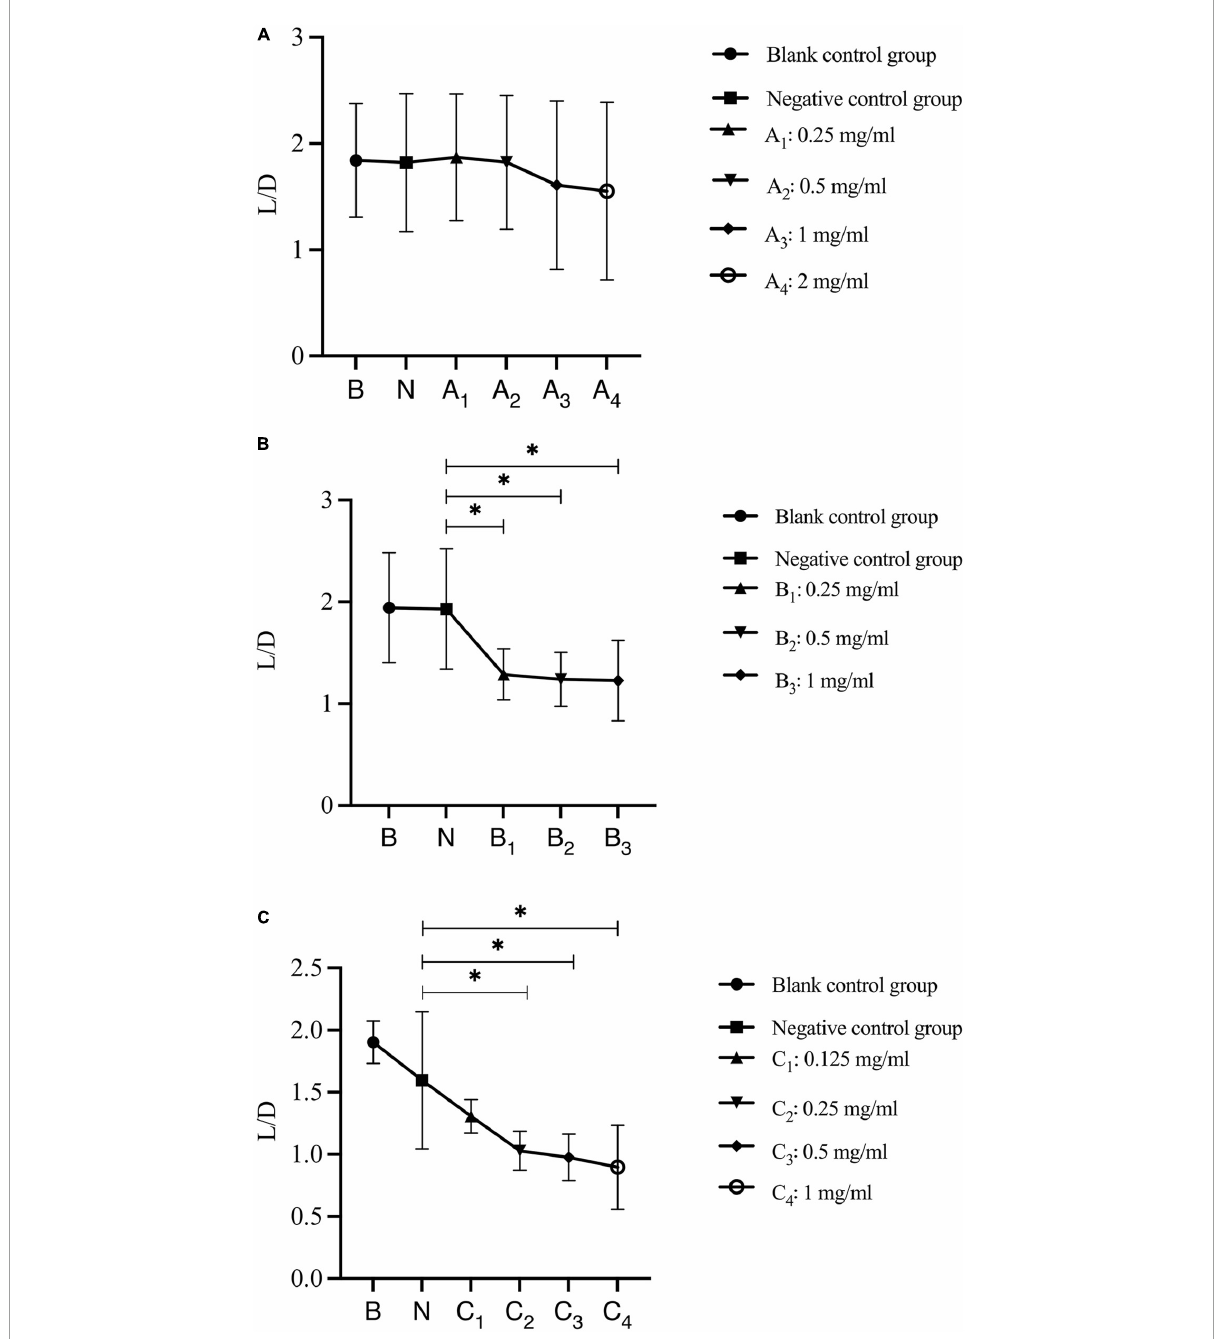
FIGURE8 Changes in the ratio of live/dead bacteria after bovine trypsin treatment for 30 s, 1 min, and 3 min. (A–C) Show the quantitative analysis of the ratio of live bacteria/dead bacteria in the biofilms after 30 s, 1 min, and 3 min of bovine trypsin treatment, respectively. ∗ Indicates that there is a statistically significant difference compared with the negative control group ( P <